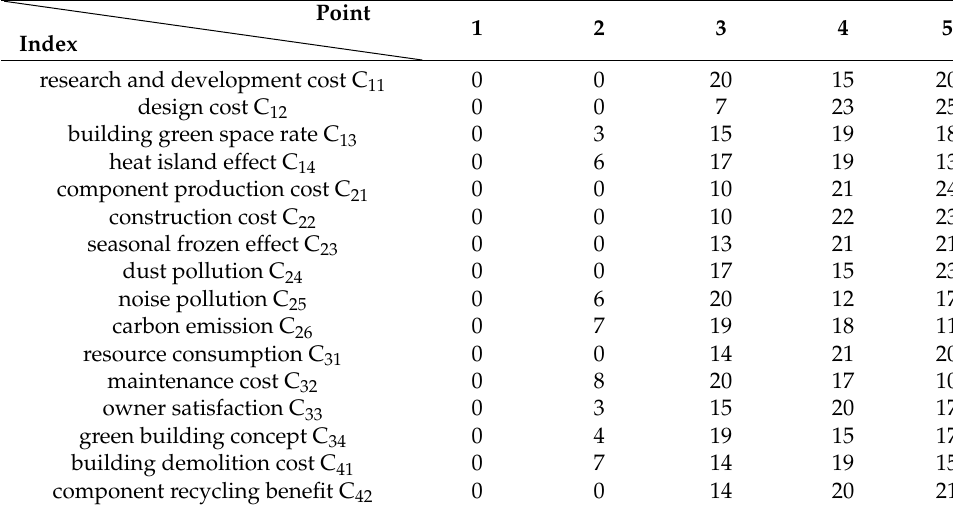
Table 1. Questionnaire survey